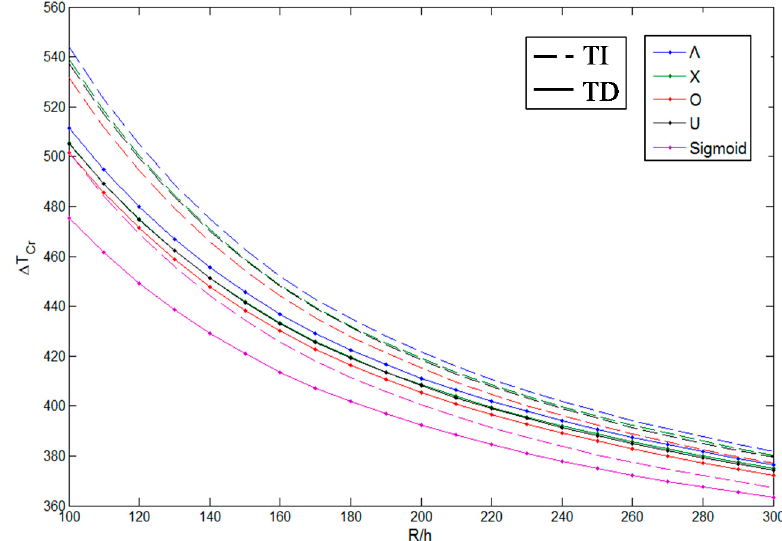
Figure 4. Effect of different CNT profiles on the critical thermal buckling load considering L / R = 2, = 0.17, A = 1000, w = 0.425, N r = N s = V ∗ R CNT